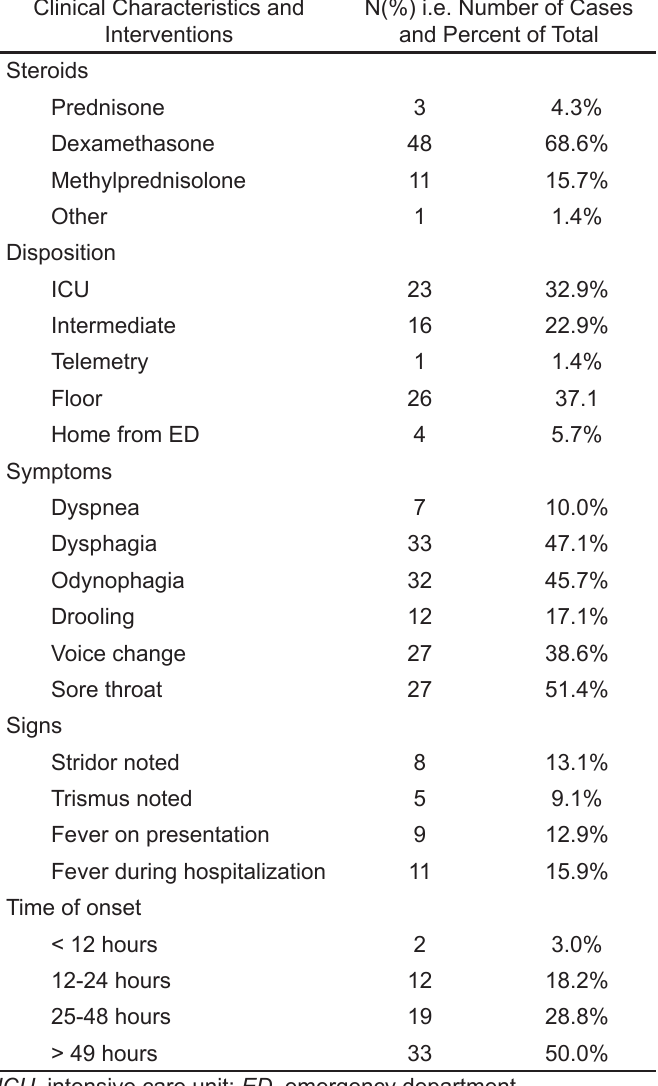
Table 2. Clinical characteristics and interventions. Table 3. Diagnostic testing.